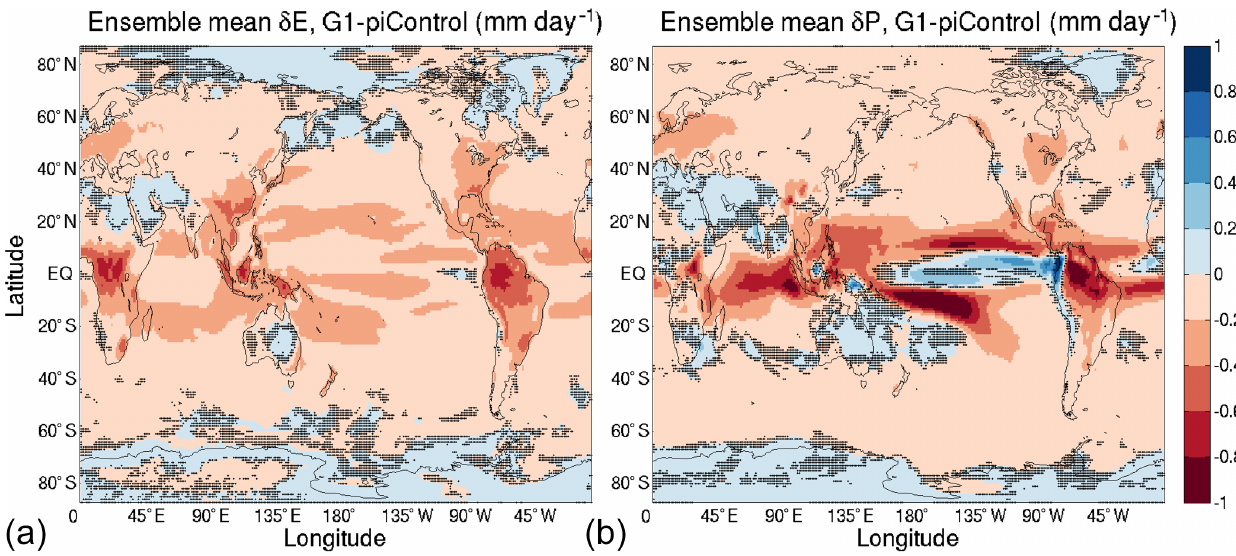
Figure 3. The annual mean distribution of evaporation (a) and precipitation (b) rate anomalies (mmyear − 1 ) between G1 (years 11–50) and piControl (all years) averaged among 11 models (EC-Earth excluded due to unphysical result). The stippling indicates where fewer than 64% of the models agree on the sign of the change. These results appear in Kravitz et al.